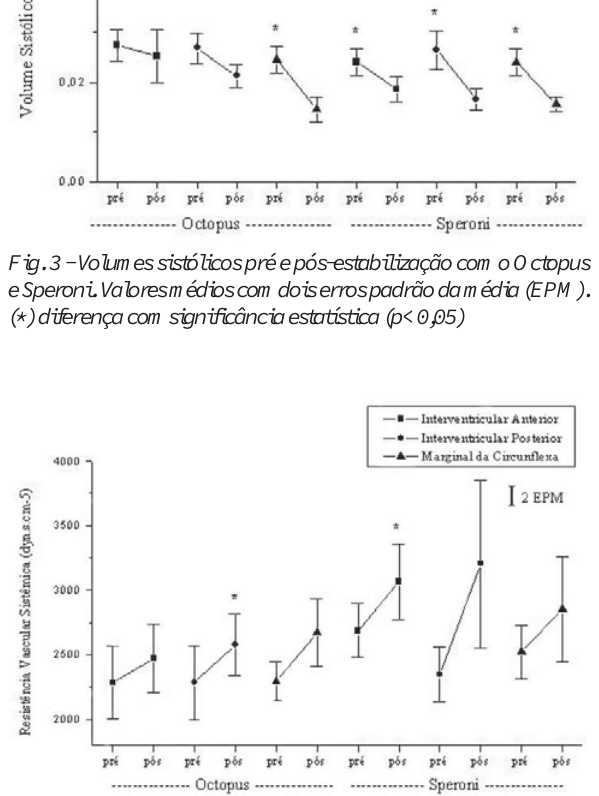
Fig. 4 - Resistências vasculares sistêmicas pré e pós-estabilização com o Octopus e Speroni. Valores médios com dois erros padrão da média (EPM). (*) diferença com significância